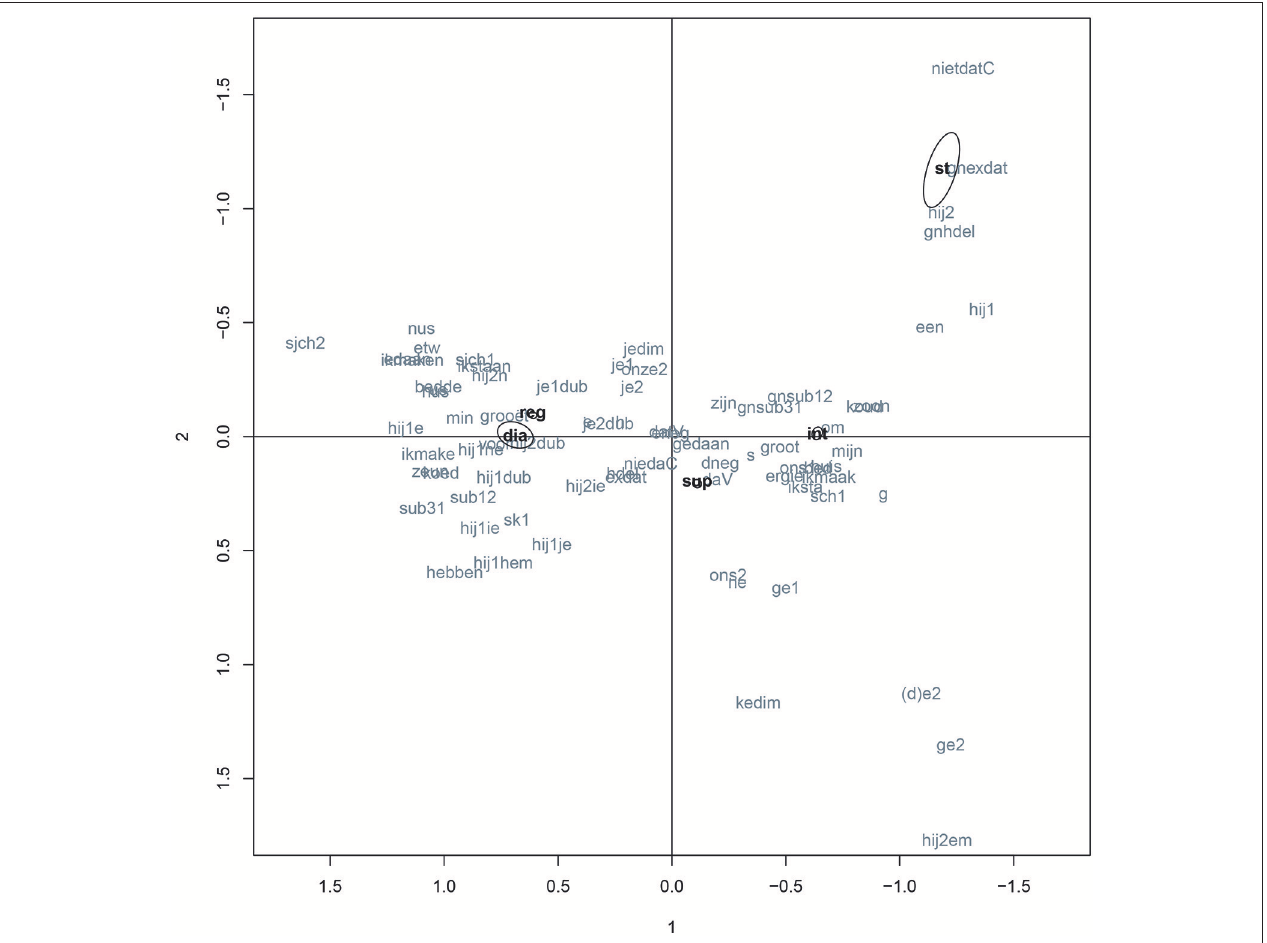
FIGURE 2 | Correspondence plot Ieper with main effects for situation 14